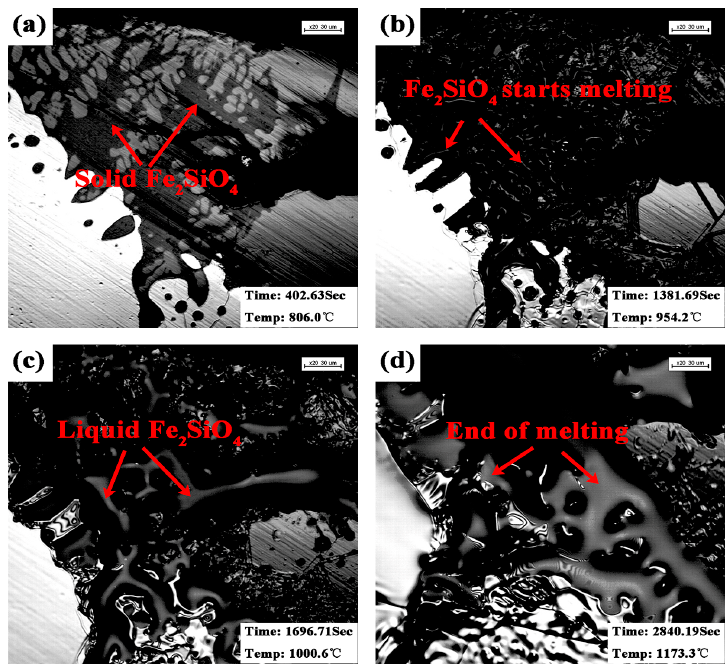
Figure 7. Micrographs showing results from in situ observations of the melting process of Fe 2 SiO 4 for steel SiP ‐ 2 ( a ) before melting; ( b ) at the start of melting; ( c ) during melting; ( d ) at the end of melting.